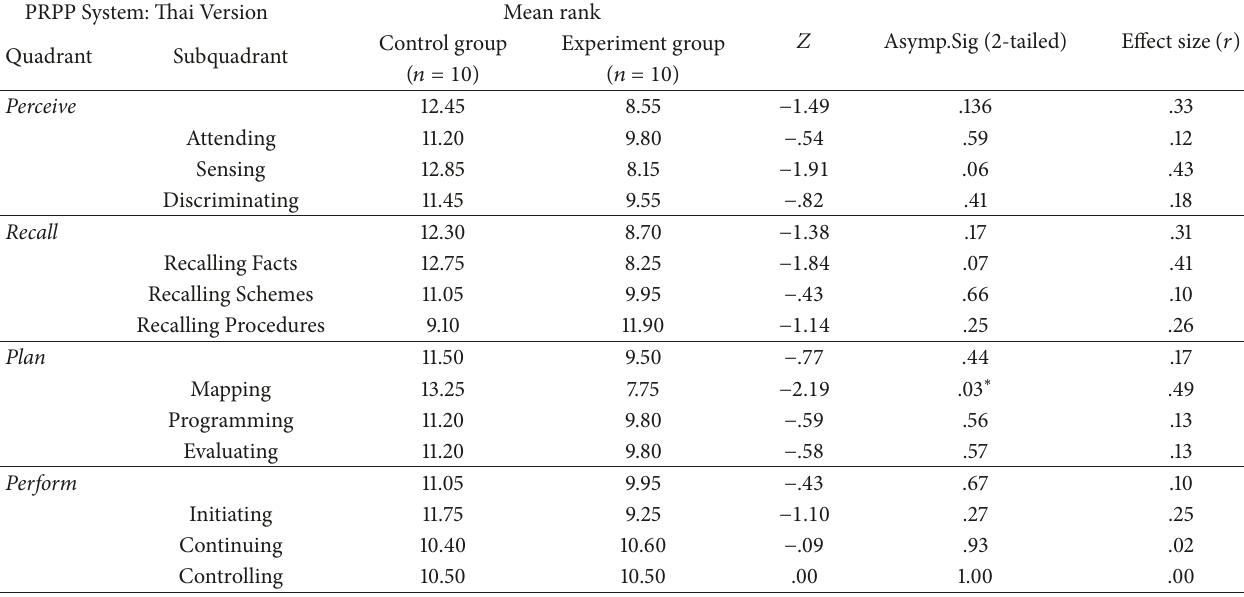
Table 5: The comparison of the quadrant and subquadrant pretest scores between the control and experimental group on the academic activity (reading comprehension and written expression).